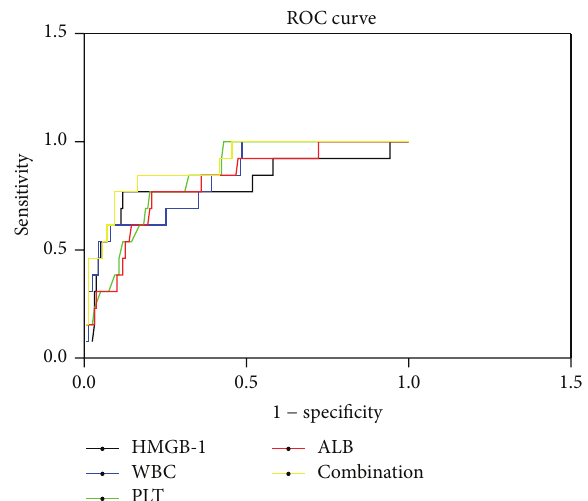
Figure 3: Use of HMGB-1, WBC, PLT, and ALB in combination to predict prognosis in patients with HFRS by ROC analysis. ROC, receiver operating characteristic; HMGB-1, high mobility group box protein-1; WBC, white blood cells; PLT, platelets; ALB, albumin.